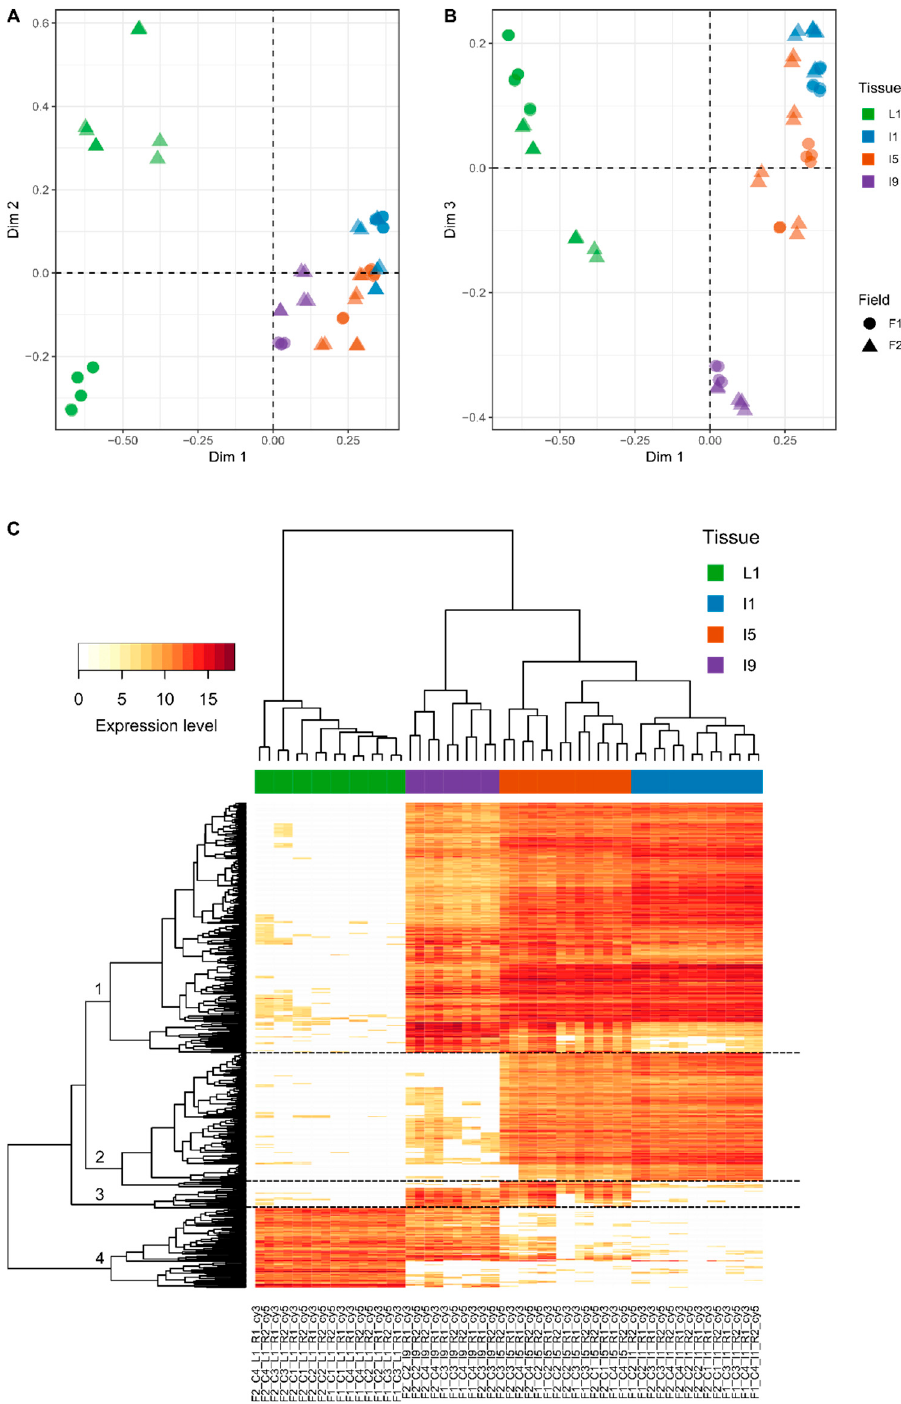
Figure 3. Multidimensional scaling (MDS) analyses of the transcriptomics data demonstrated that most of the variation within transcriptomics profiles is attributed to the differences between the distinct anatomical tissues. ( A ) Dim1 vs. Dim2; ( B ) Dim1 vs. Dim3. ( C ) Heatmap constructed using the top 500 most variable genes responsible for the variations in the different tissues. L1, I1, I5, and I9 refer to leaf +1 and immature, intermediate, and mature internodes. F1 and F2 refer to the plants that were planted in April 2012 and October 2012, respectively. C1, C2, C3, and C4 refer to sampling points at 4, 8, 11, and 13 months after